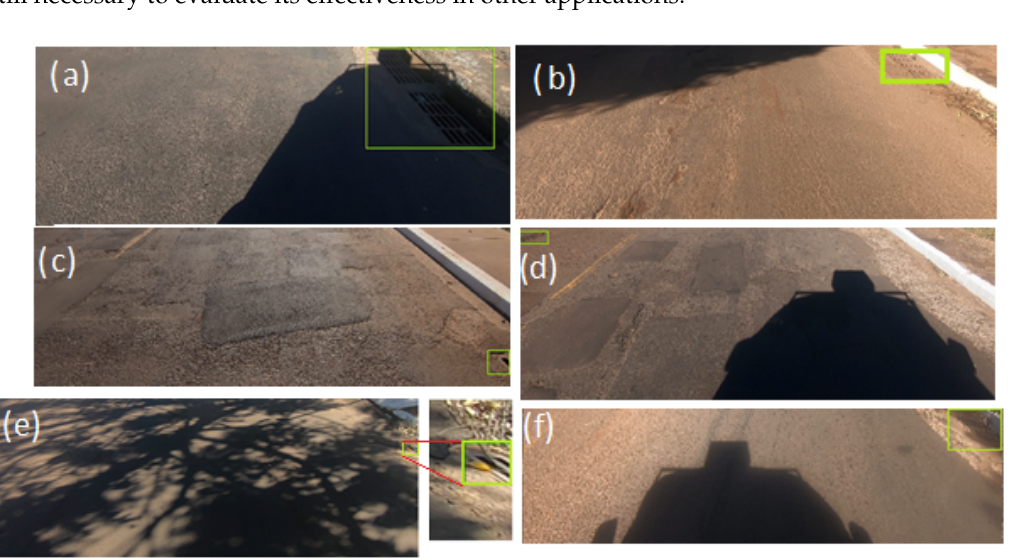
Figure 7. Examples of images that some models did not predict the bounding boxes to the division 76-12-12 considering ( a ) shadow presence, ( b ) small size objects, ( c ) small size objects truncated, ( d ) small size objects, ( e ) small size objects with shadow presence and ( f ) shadow